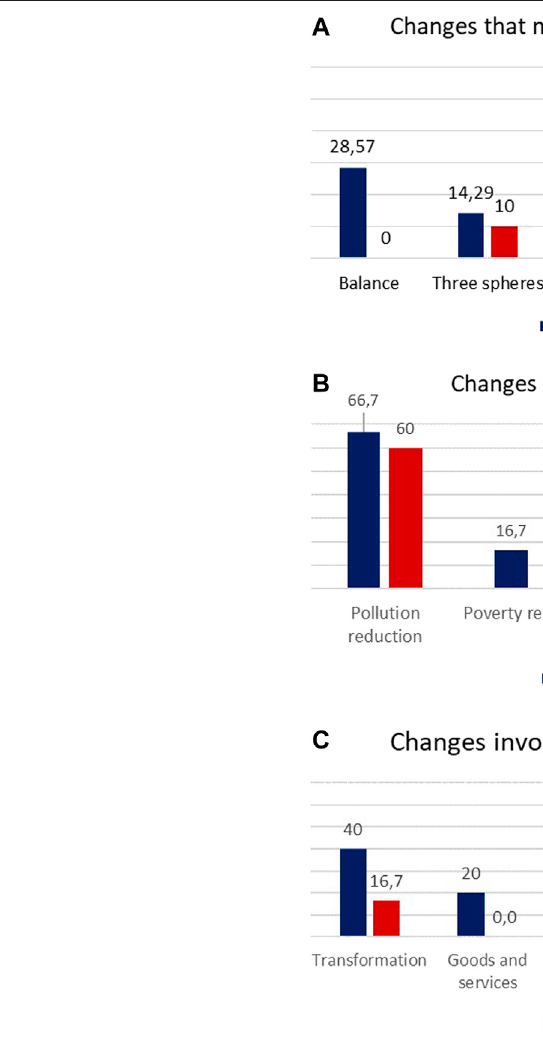
FIGURE 6 | Semantic Richness According to the Category magnitude of changes in consumption patterns (A) Changes that maintain the status quo (B) Changes involving reforms (C) Changes involving transformation.